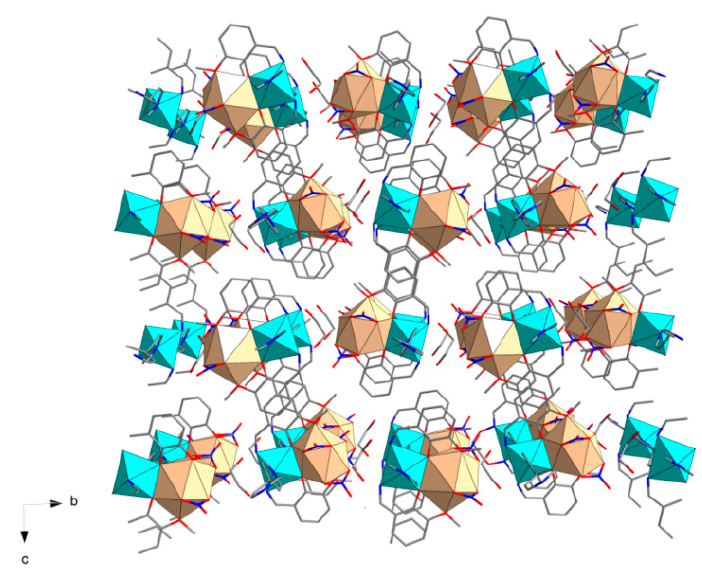
Figure 9. View of the three-dimensional supramolecular structure of the title polymer.